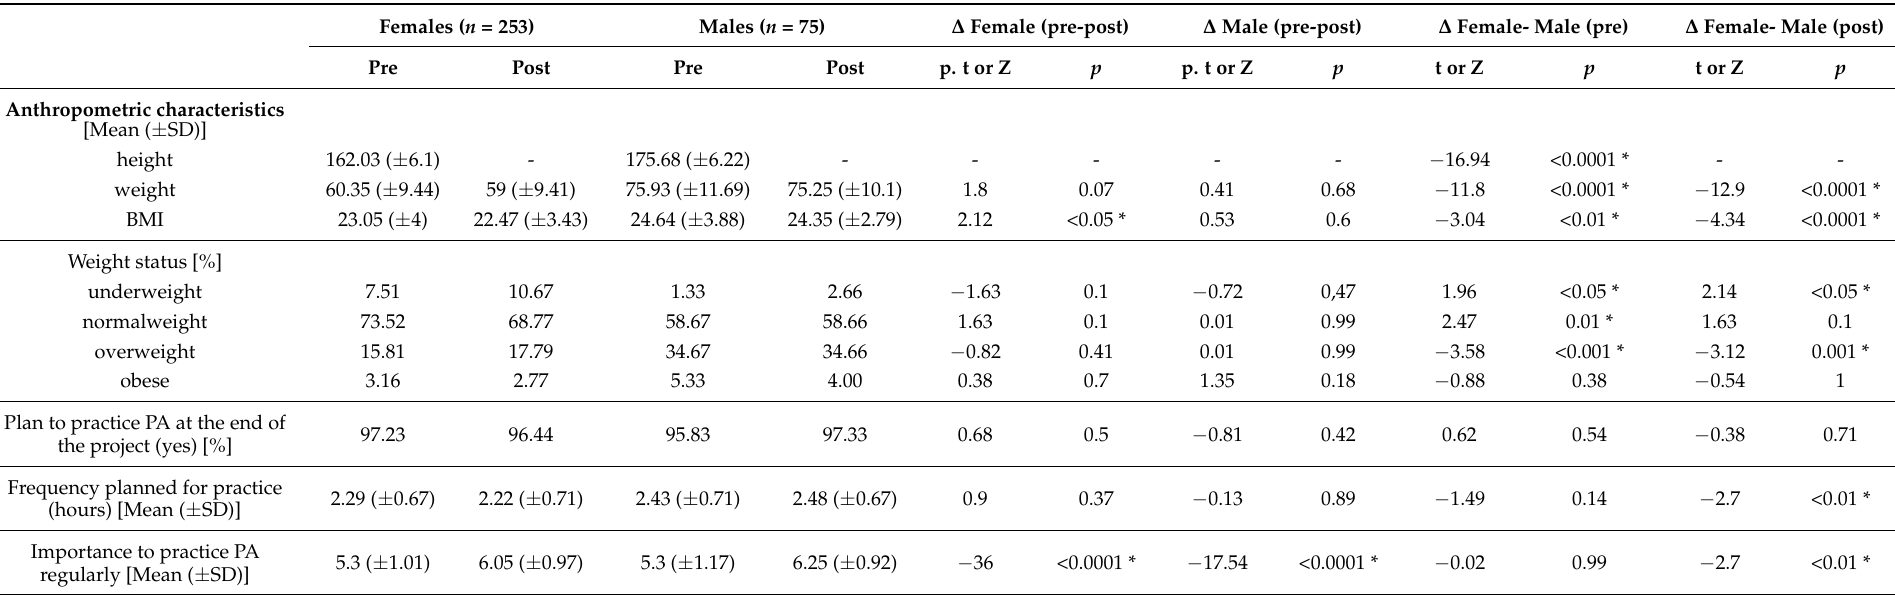
Table 2. Mean and proportion differences within and between